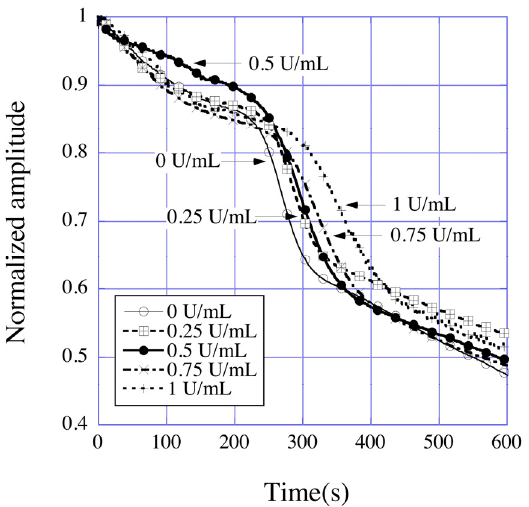
Figure 30. Time dependent normalized amplitude of the resonance peaks of magnetoelastic sensors immersed in blood containing different heparin concentrations. Reprinted with permission from